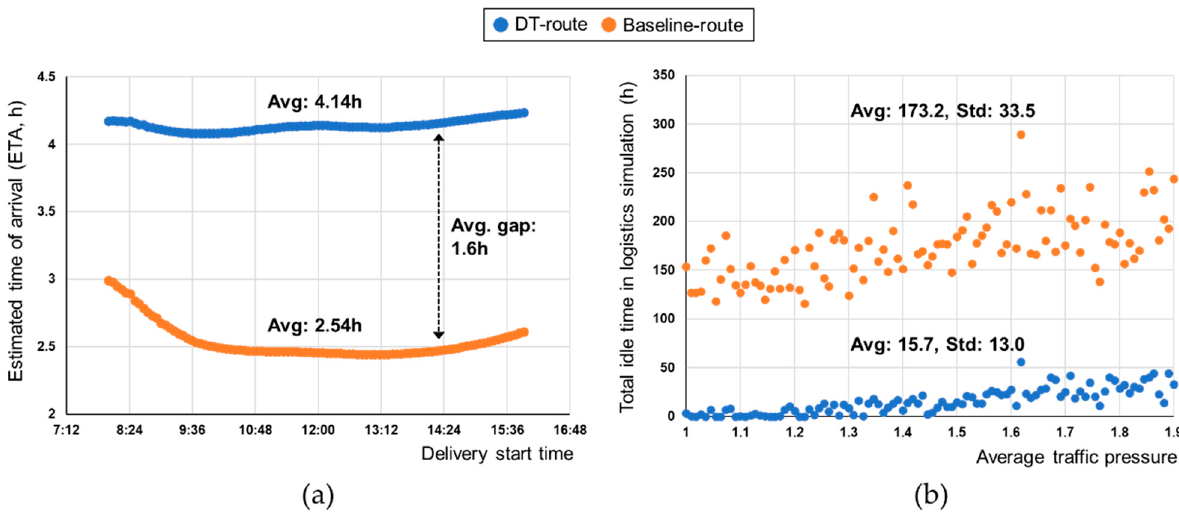
Figure 4. Results of logistics simulation: ( a ) Average ETA for a module; ( b ) Total idle time for 80 modules.